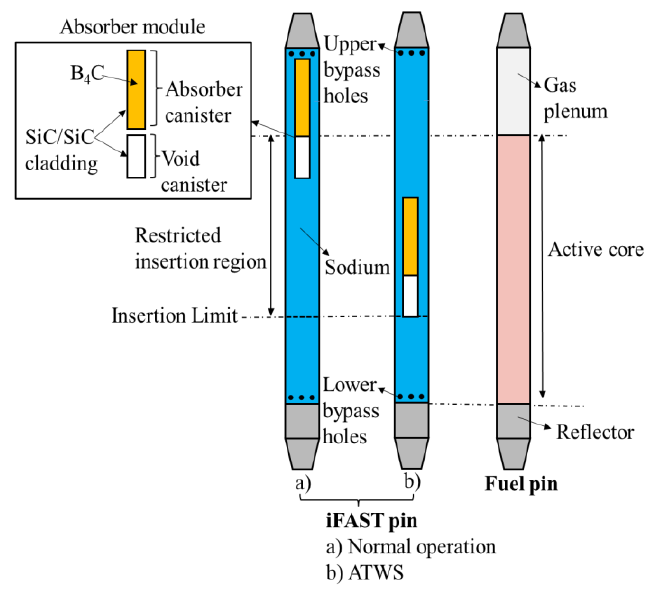
Figure 1. Concept of the iFAST device.